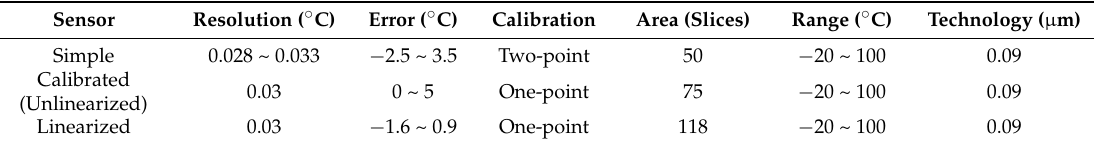
Table 1. Measured performances of the three versions for easy